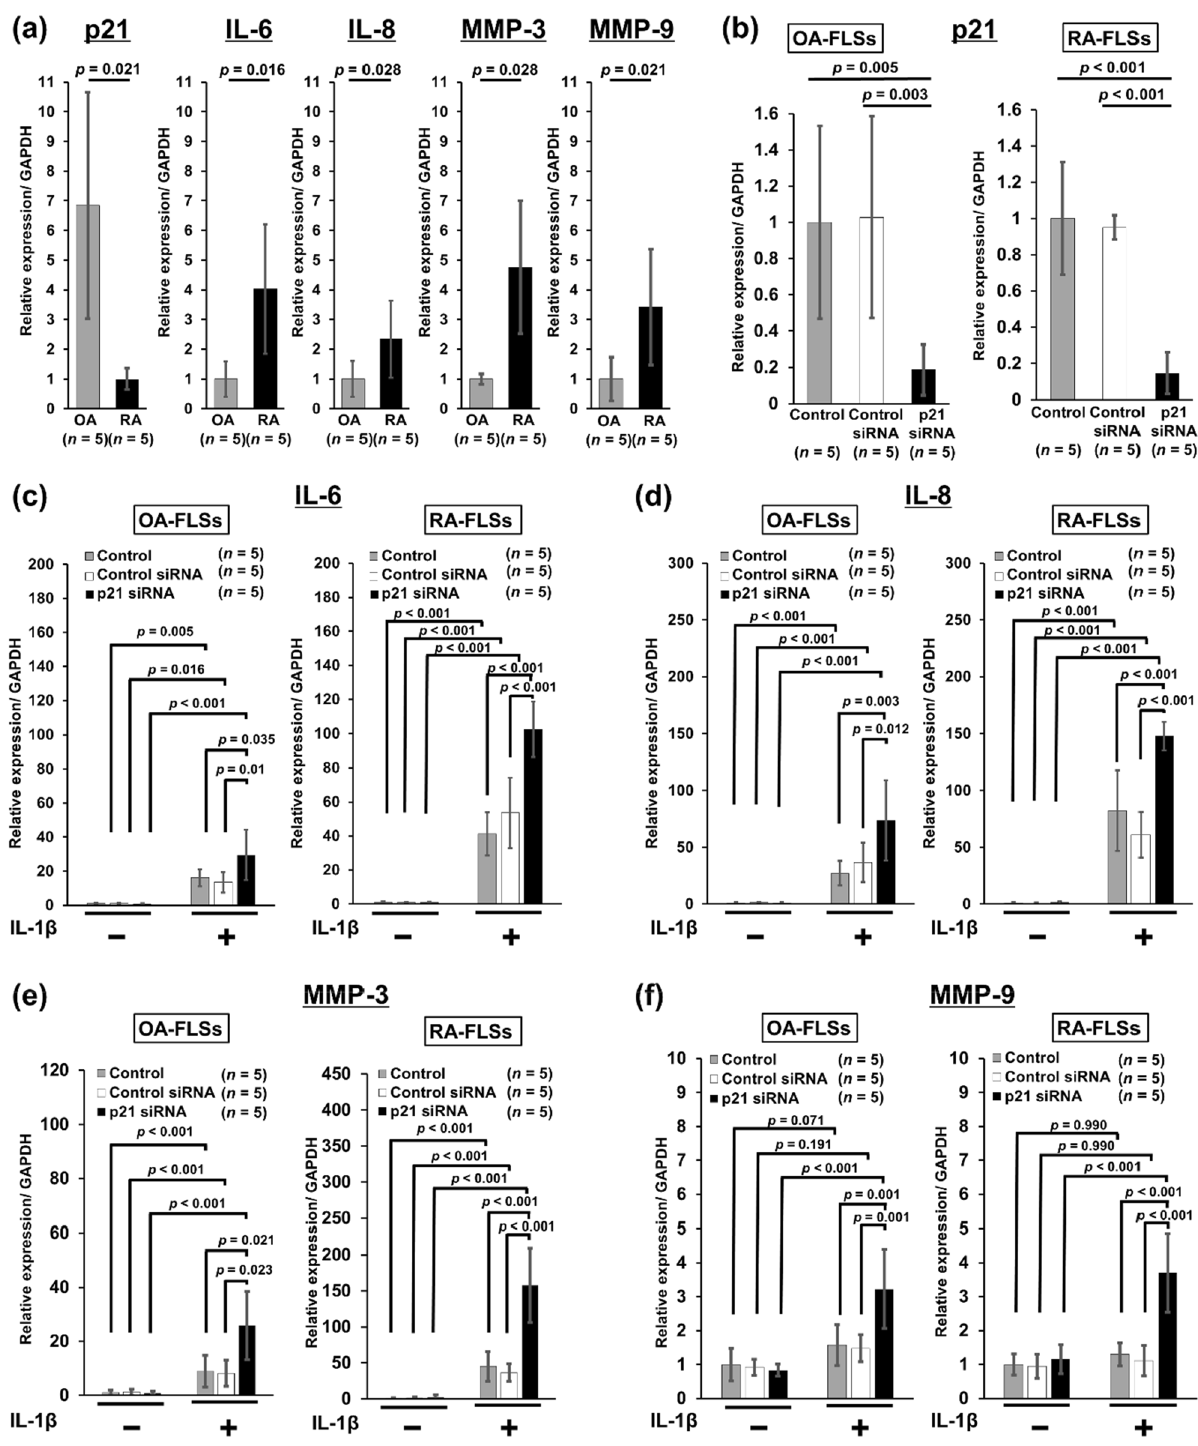
Figure 5. Knockdown of the p21 gene affects IL-6 , IL-8 , and MMP expression in rheumatoid arthritis and osteoarthritis synovial tissues. ( a ) The relative expression of p21 , IL-6 , IL-8 , MMP-3 , and MMP-9 mRNA was determined in fibroblast-like synoviocytes (FLSs). ( b ) FLSs were transfected with p21 siRNA or nonspecific control siRNA for 24 h, and the relative expression of p21 mRNA was determined. The relative expression of ( c ) IL-6 , ( d ) IL-8 , ( e ) MMP-3 , and ( f ) MMP-9 mRNA was determined after transfection with p21 siRNA or nonspecific control siRNA and treatment with or without 10 ng/ml recombinant human IL-1β for 24 h. The relative expression of IL-6 , IL-8 , MMP-3, and MMP-9 mRNA with respect to the control is shown with 95% CI. Five human synovial tissues were analyzed from each group. In ( a ), the Mann–Whitney U test was used for comparisons between two groups. In ( b ), one-way analysis of variance and Tukey’s post hoc test for multiple comparisons of paired samples were used. In ( c – f ), two-way analysis of variance and Tukey’s post hoc test for multiple comparisons of paired samples were used. CI confidence interval, FLSs fibroblast-like synoviocytes, p21 cyclin-dependent kinase inhibitor